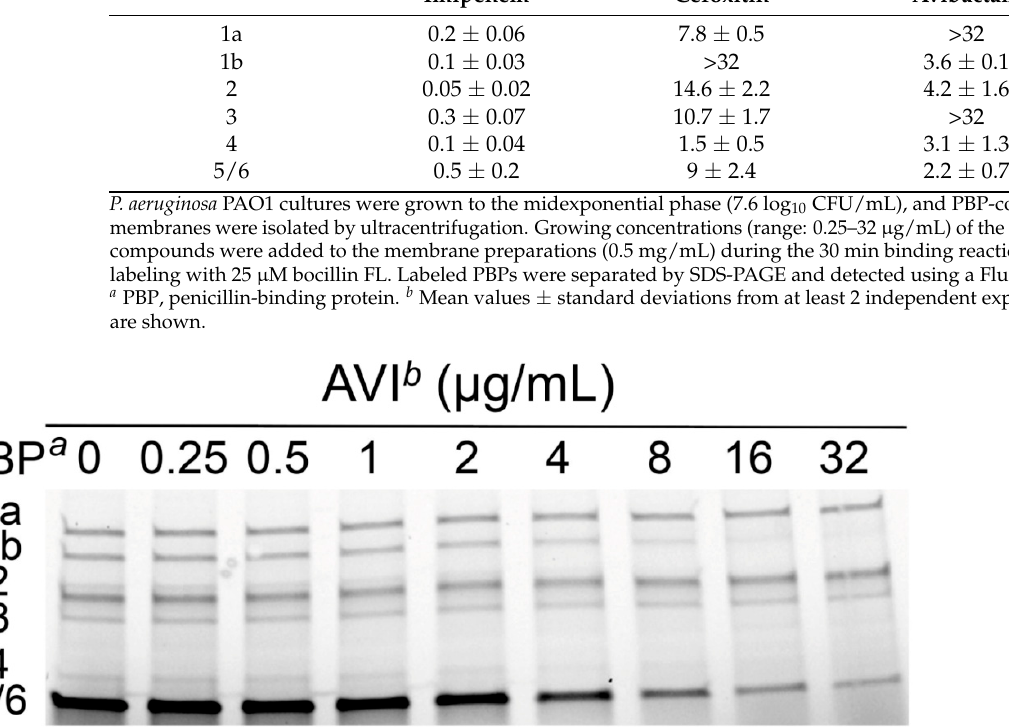
Figure 1. Illustrative example of a PBP-binding IC 50 SDS–polyacrylamide gel. P. aeruginosa PAO1 cultures were grown to the midexponential phase (7.6 log 10 CFU/mL), and membranes were isolated by ultracentrifugation. Isolated PBP- containing membrane preparations (0.5 mg/mL) were incubated in the presence of increasing concentrations of avibactam and afterwards were labeled with 25 µ M bocillin FL. Labeled PBPs were separated by SDS-PAGE and detected using a Fluorimager. a Penicillin-binding proteins identified in P. aeruginosa PAO1. b AVI, avibactam, range of concentrations tested: 0.25–32 µ